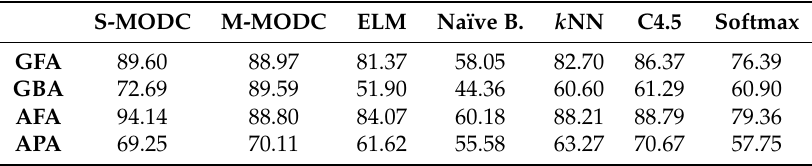
Table 11. Comparison with other machine learning